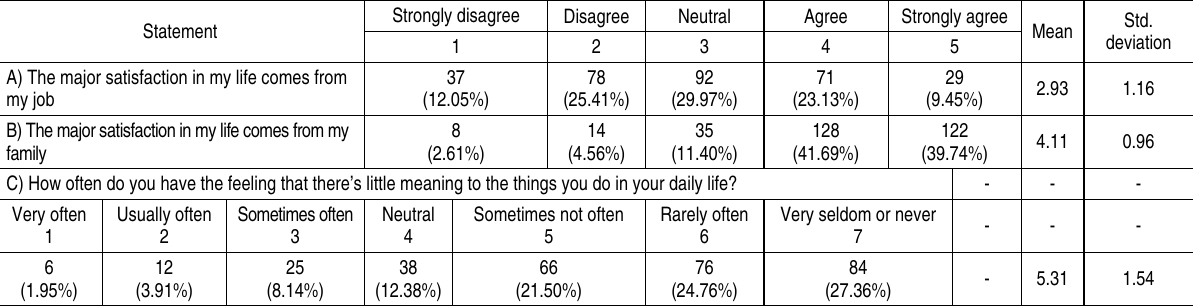
Table 1. Descriptive statistics: relationship between SOC and